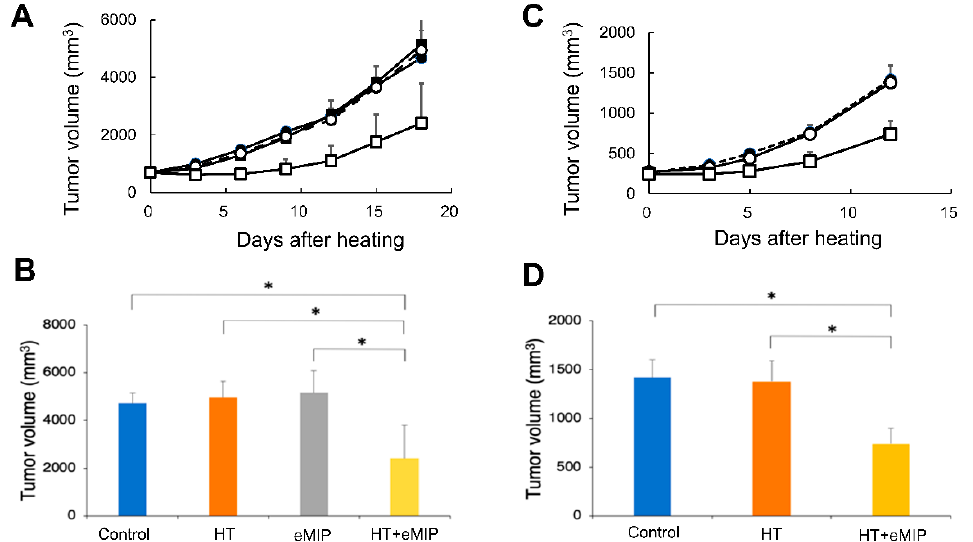
Figure 1. Effects of hyperthermia (HT), the CCL3 variant named eMIP and their combination on tumor growth. ( A ) Time course of tumor growth. Colon26 adenocarcinoma cells were